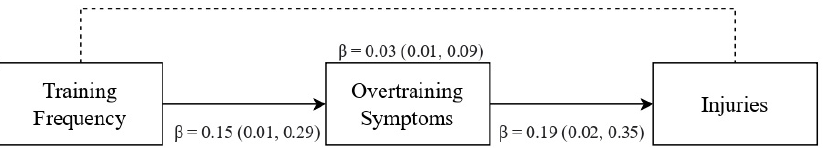
Figure 1. Path model. Notes: β = standardized beta coefficients; straight lines = direct regression path; dotted lines = indirect regression path; within brackets = 95 percent confidence interval.